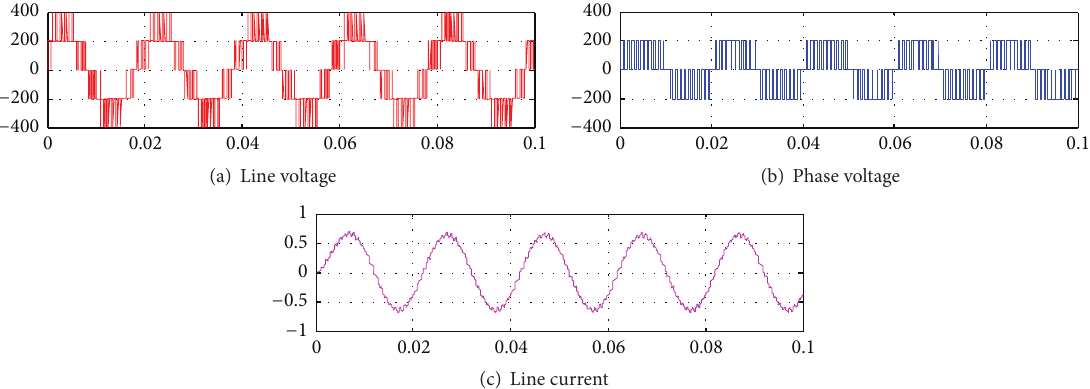
Figure 12: Five-level inverter as three-level inverter.